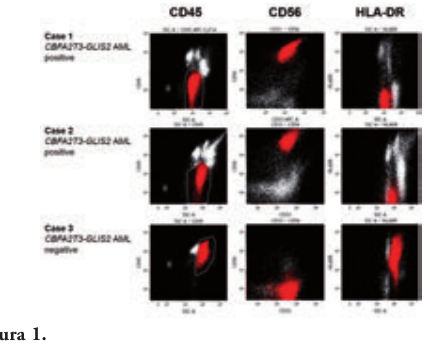
Figura 1. Le analisi supervisionate effettuate hanno rilevato che 2 su 14 antigeni erano sufficienti per identificare corretta- mente un paziente con LMA come positivo o negativo per il gene di fusione CBFA2T3-GLIS2. Il CD56 è risul- tato essere il marcatore che singolarmente presenta